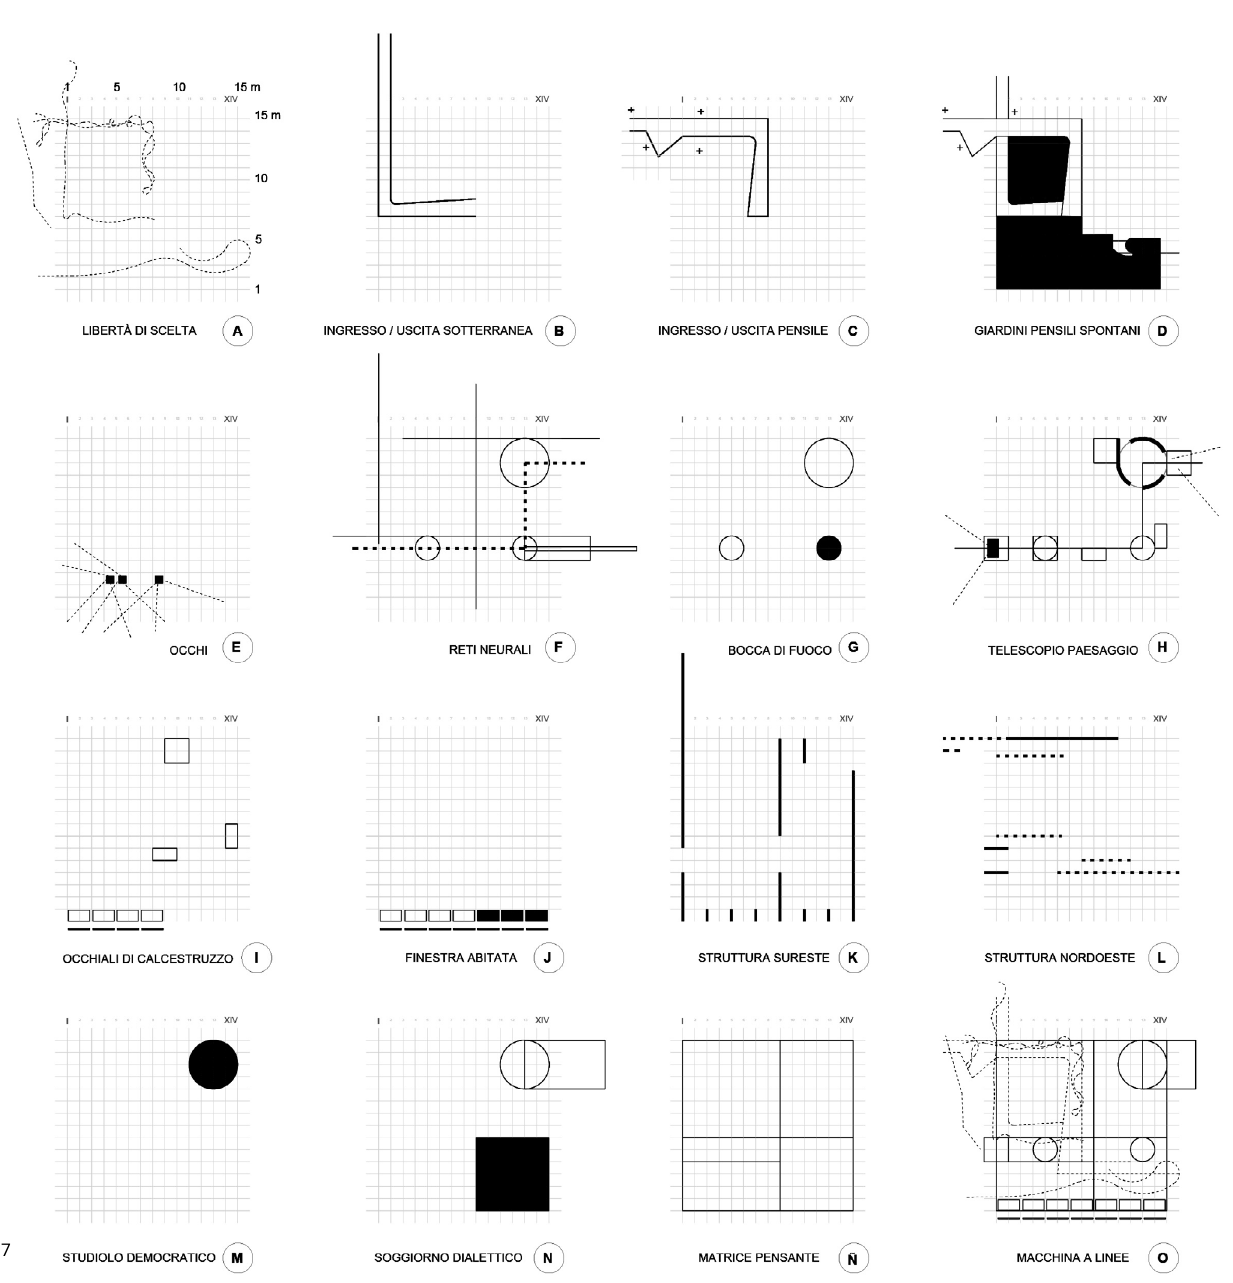
Process and elements in Ca’ Romanino. Source: